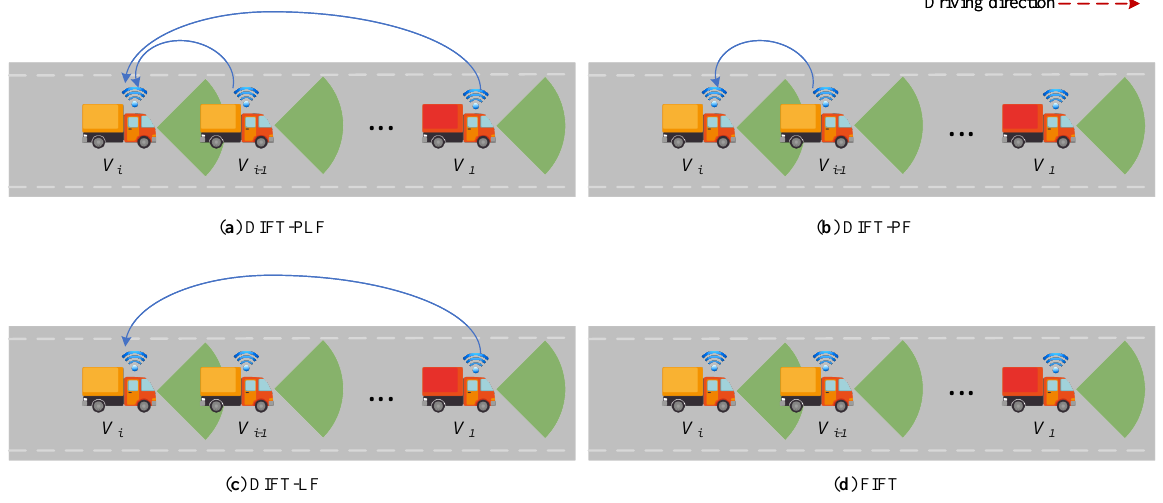
Figure 2. Different structures in IFT. ( a ) DIFT-PLF. ( b ) DIFT-PF. ( c ) DIFT-LF. ( d ) ACC of